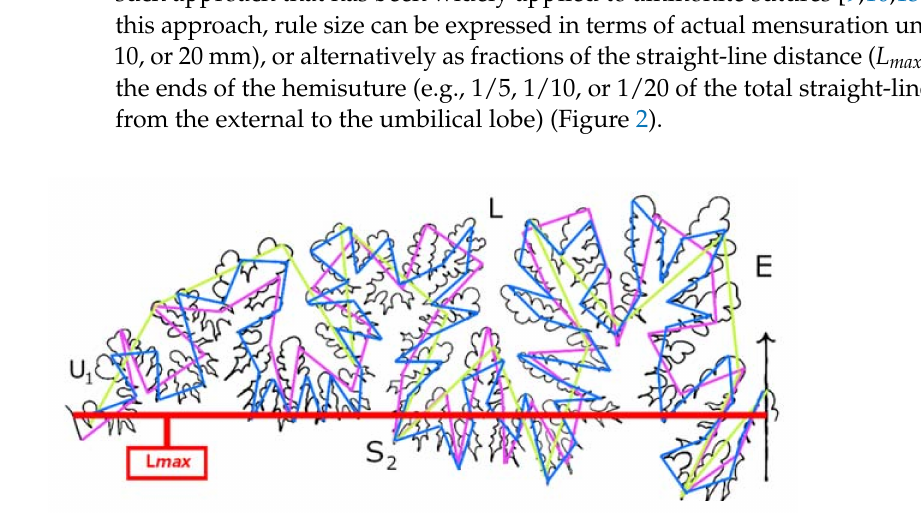
Figure 2. Step count of Eogaudryceras numidum suture using the Richardson Step Method as described by [13,14] using fractions of the hemisuture length ( L max ) as rule sizes. Green is 1/5, magenta is 1/10, and blue is 1/15. Eogaudryceras numidum suture redrawn by KM from Figure 31E in